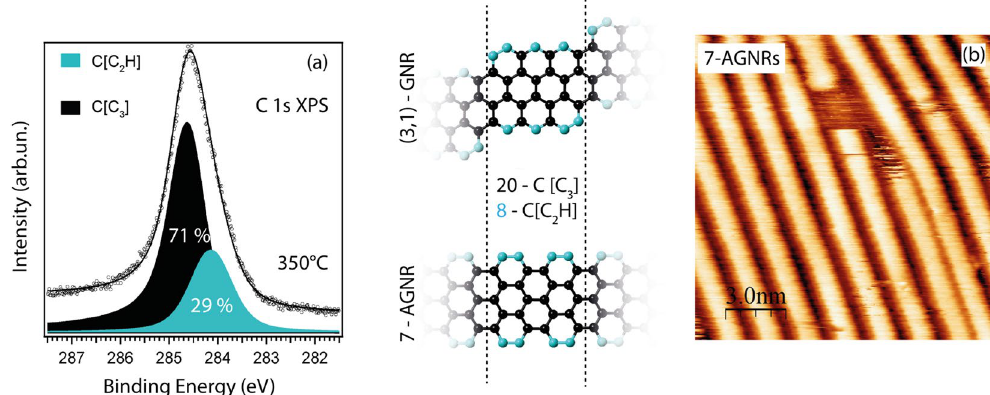
Figure 6. ( a ) C 1s XPS spectrum obtained after 350 °C annealing of polyanthracene chains on Ag(111) for 30 min. The photoemission peak is fitted in accordance with the ratio between the amounts of carbon atoms in chemically non-equivalent positions expected for both of the structural models shown to the right. The photon energy is 380 eV. ( b ) STM image which illustrates the resulting 7-AGNRs. Tunneling parameters (VS/IT): + 1 V/500